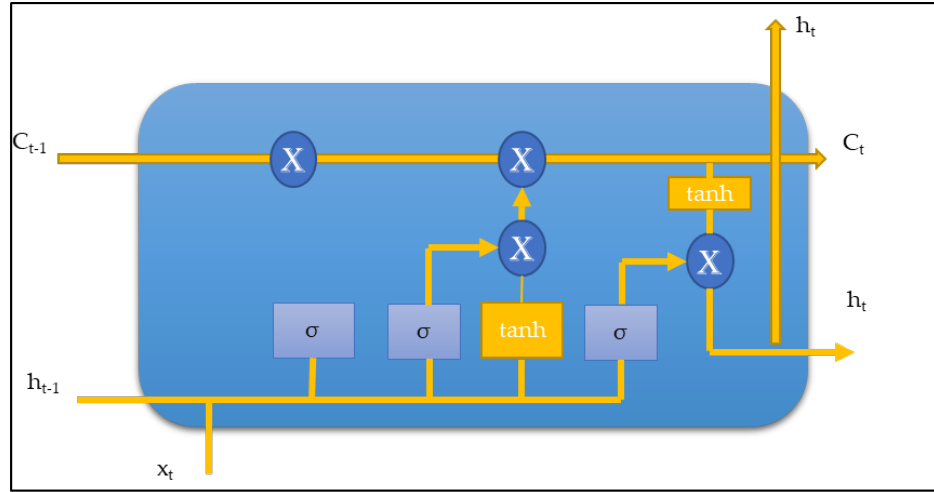
Figure 5. Basic LSTM block with memory gates.